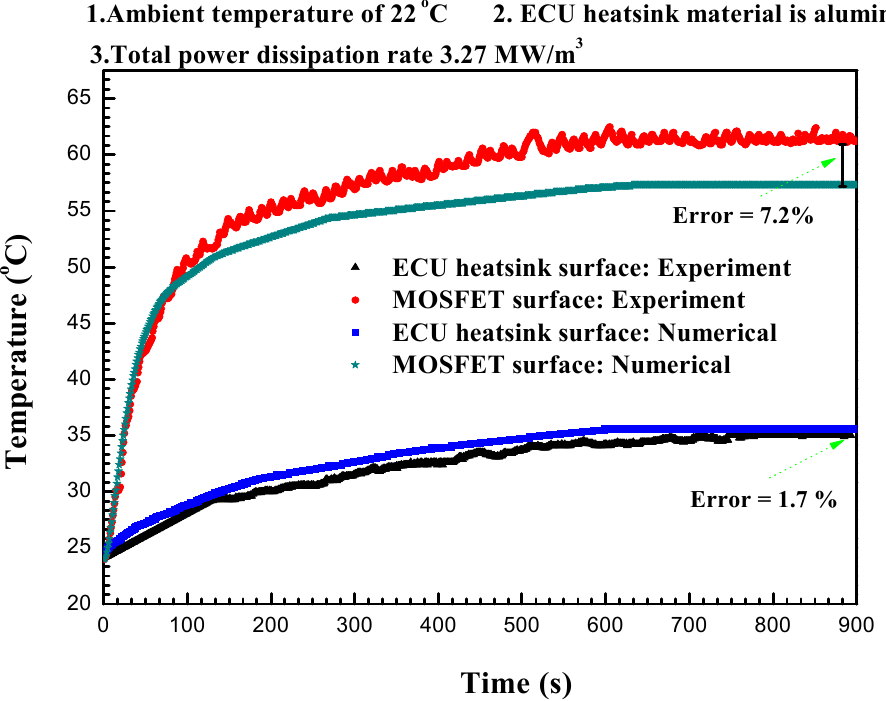
Figure 7. Experimental and numerical results of the temperature of the ECU heatsink for the 36V ECU system at a speed of 30 km/h and an ambient temperature of 22 °C.